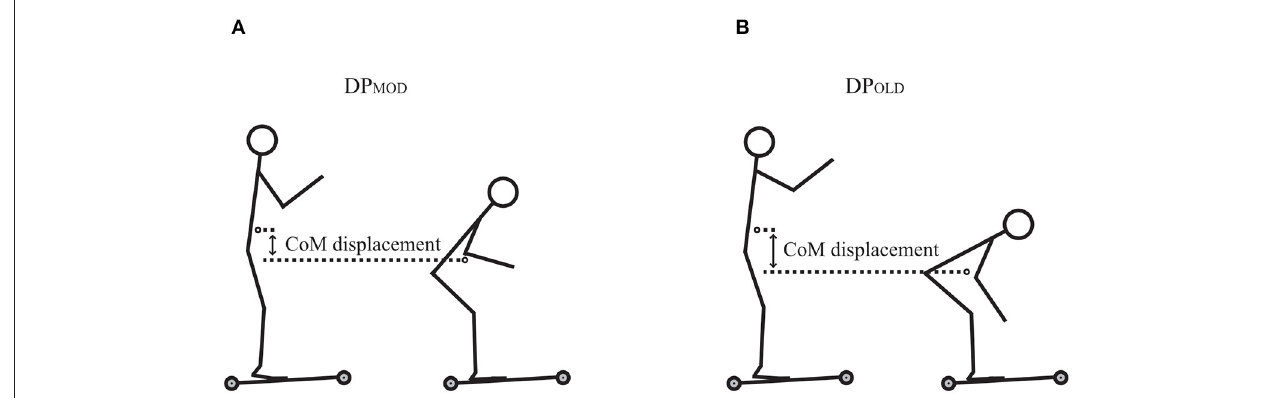
FIGURE 2 | Skiers’ mean vertical center of mass (CoM) displacement between the highest and lowest positions in the (A) DP MOD and (B) DP OLD tests.